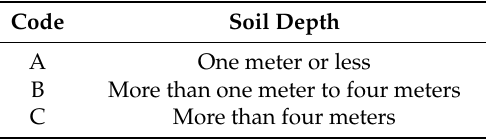
Table 4. Soil depth